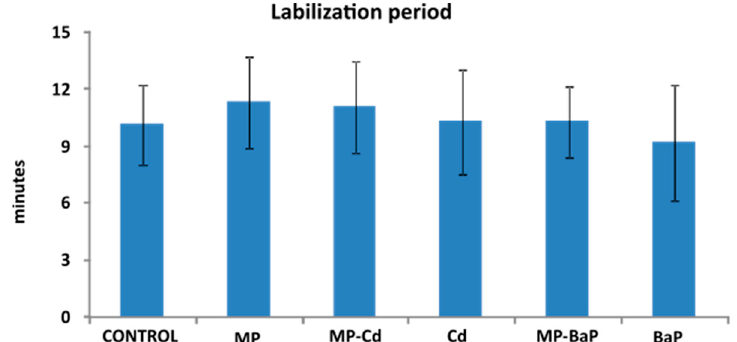
Figure 4. Labilization period (LP) of the digestive cell lysosomes. Mean ± standard deviation ( n = 10). Statistically significant differences were not found according to the Kruskal–Wallis test ( p <